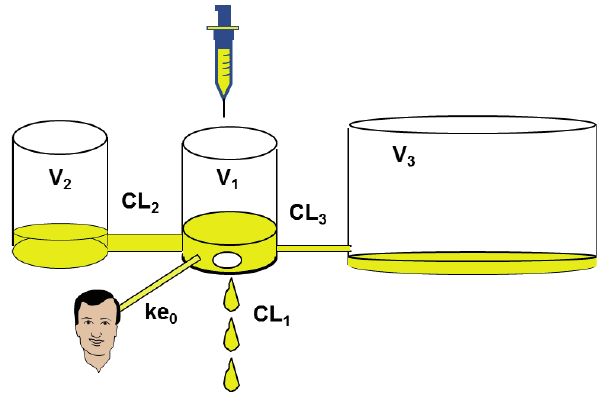
Figure 1. Three-compartment pharmacokinetic model. CL